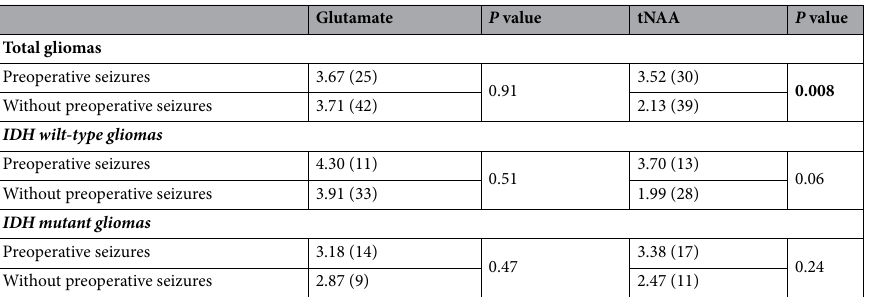
Table 4. Glutamate and tNAA quantification based on MRS and its association with preoperative seizures. bold values indicate in p < 0.05 and consequently two analyzed categories were considered to be significantly different. IDH, isocitrate dehydrogenase ; tNAA total N -acetyl-l-aspartate. The numbers in the parenthesis indicate the number of analyzed cases patients who fulfilled the inclusion criteria based on %SD values.